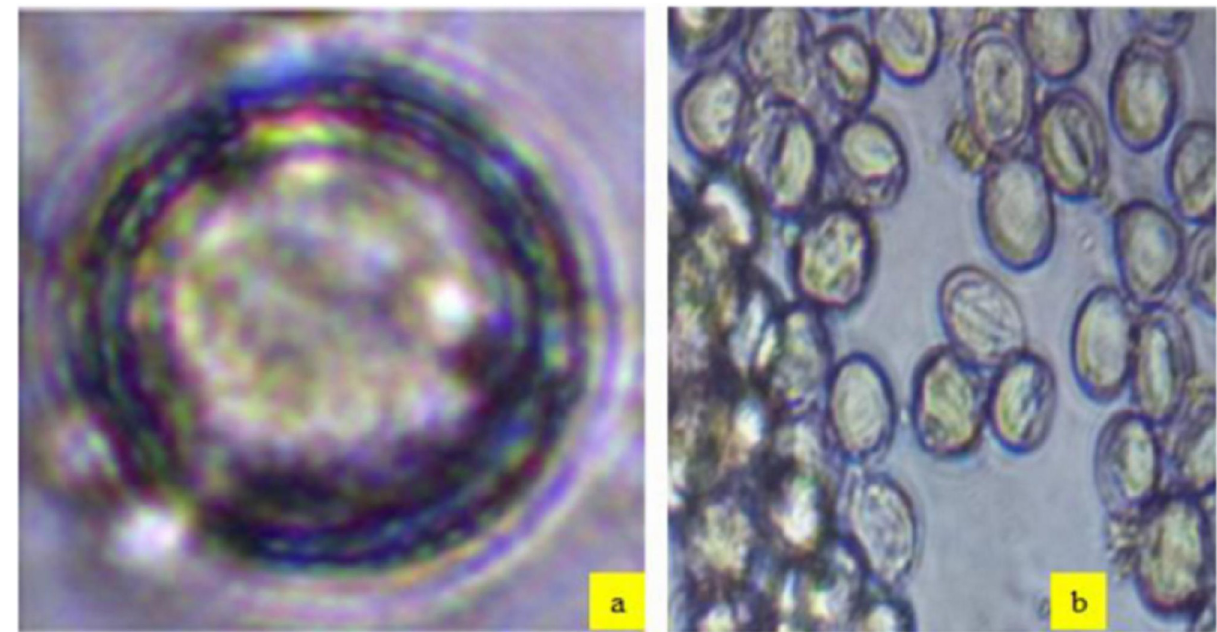
Fig 1. Pollen morphology of Schefflera abyssinica monofloral honey (a) and polyfloral honey (b).